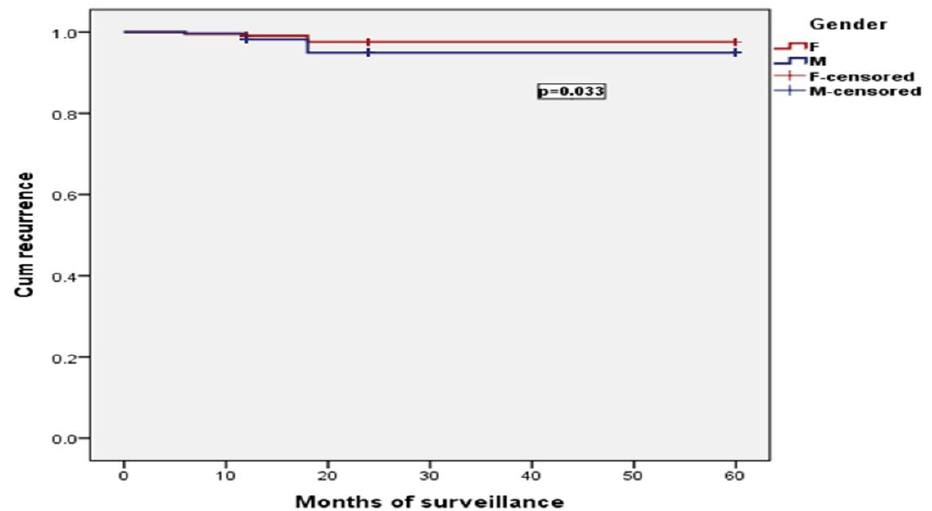
Figure 2. The frequency of recurrence was statistically significantly influenced by the gender of the patients ( p < 0.001).